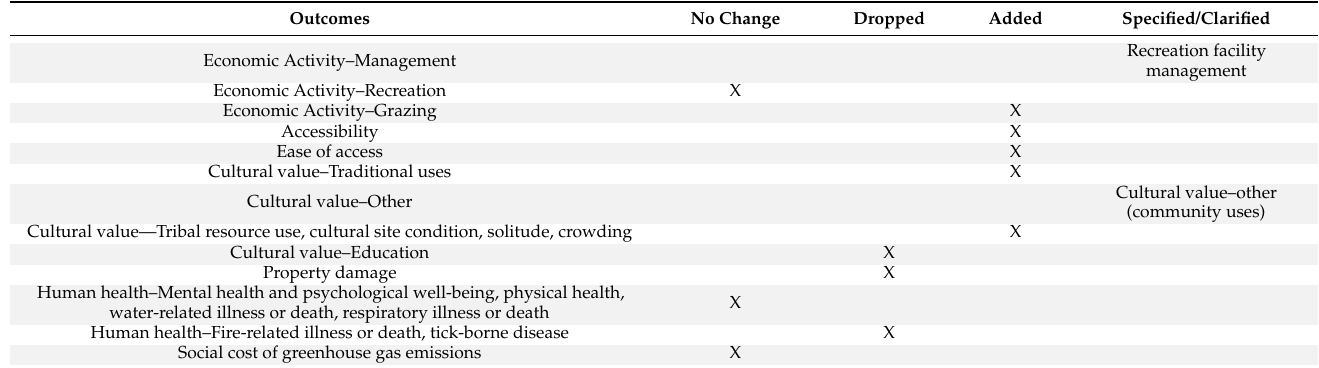
Table 1. Changes in ecosystem services outcomes between the generic, project-scale recreational model, and the Ashley National Forest Plan scale model. The X indicates whether the outcomes was not changed, dropped or added in the transition from a project scale to a planning scale